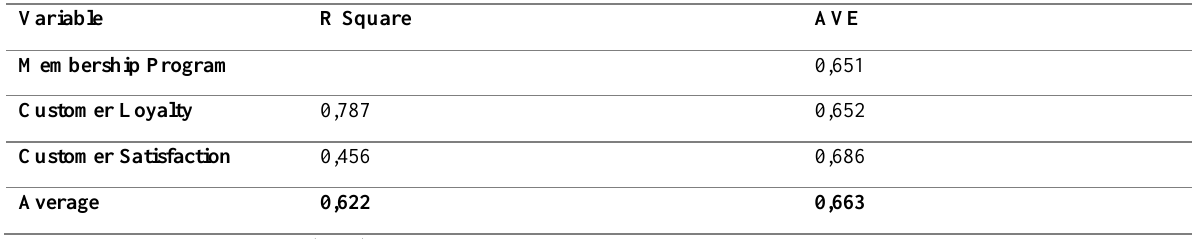
Table 5: The Goodness of Fit Model Test